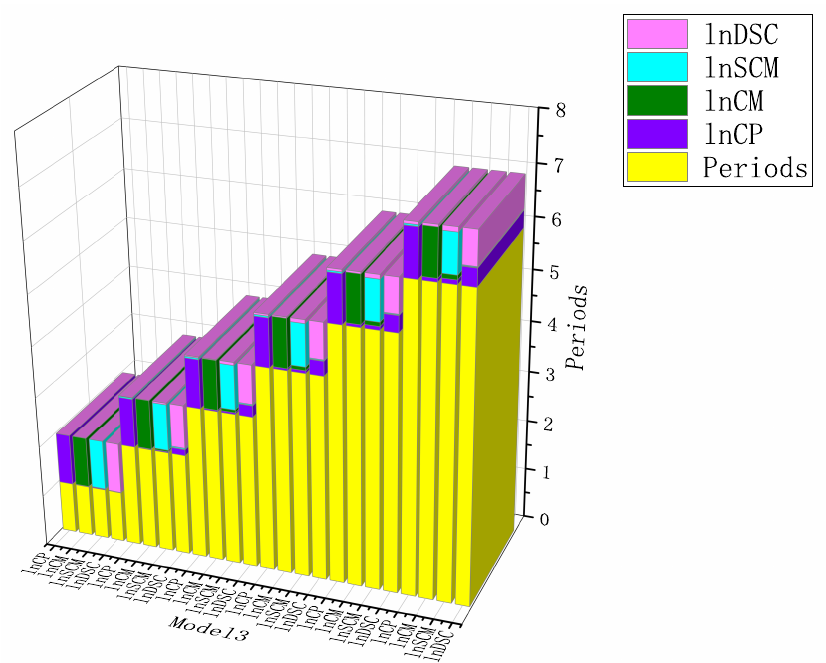
Figure 14. The graph shows the results of the variance decomposition of Model 3. The horizontal axis indicates the different variables including debt servicing capacity (lnDSC) (in Magenta), supply chain management (lnSCM) (in light blue), corporate management (lnCM) (in green), and corporate performance (lnCP) (in blue), the vertical axis indicates the contribution of each variable at different lags (see Appendix A for specific figures), and the yellow area indicates the number of periods lagged.